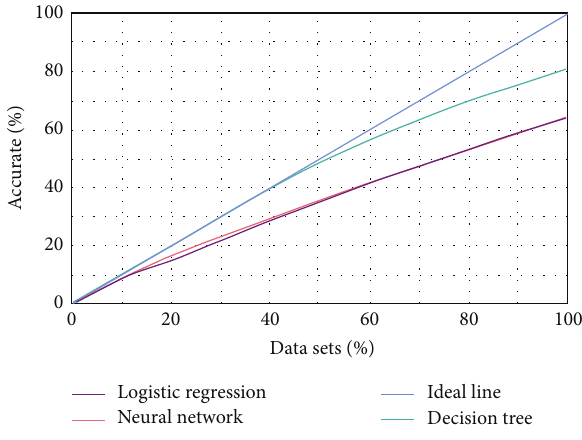
Figure 4: The lift map of data